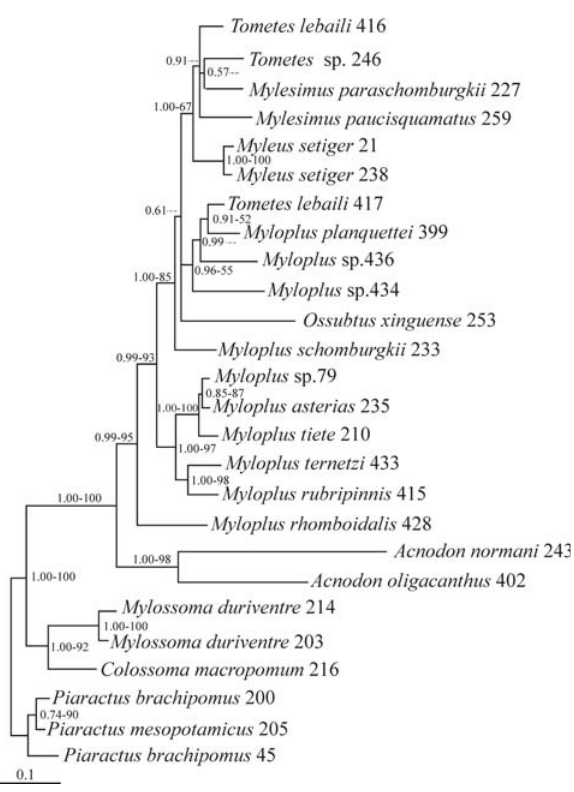
Figure 3 - Phylogeny for the pacu and Myleus groups, obtained with Bayesian inference based on control region mtDNA sequences (1180 bp) and indel characters (119 characters). The combined data were partitioned into two categories, each with its independent model (Nst = 6 and rates = pinvar for DNA, and the standard model with rates = gamma for indel characters, see text for more details). Numbers next to nodes are posterior probabilities followed by a dash and bootstrap values (BV) from the maxi- mum parsimony